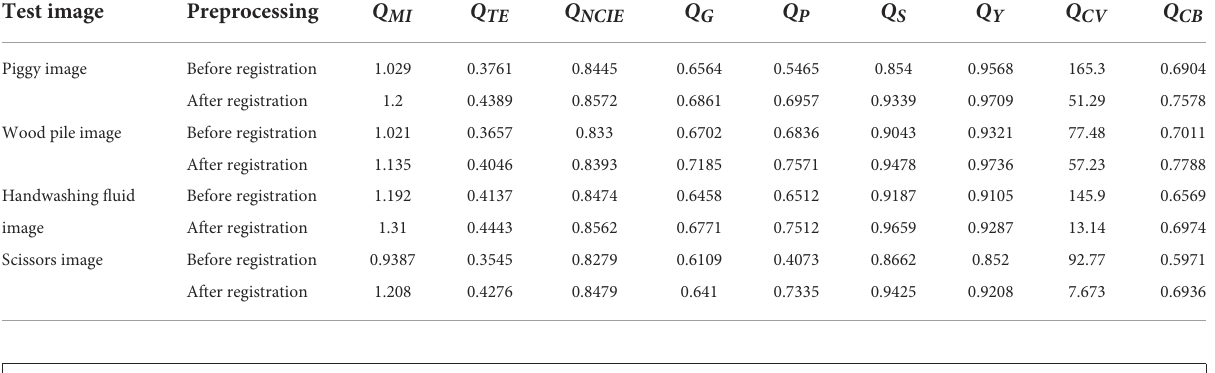
TABLE 2 The nine metrics’ values of the fused images before and after image registration. Test image